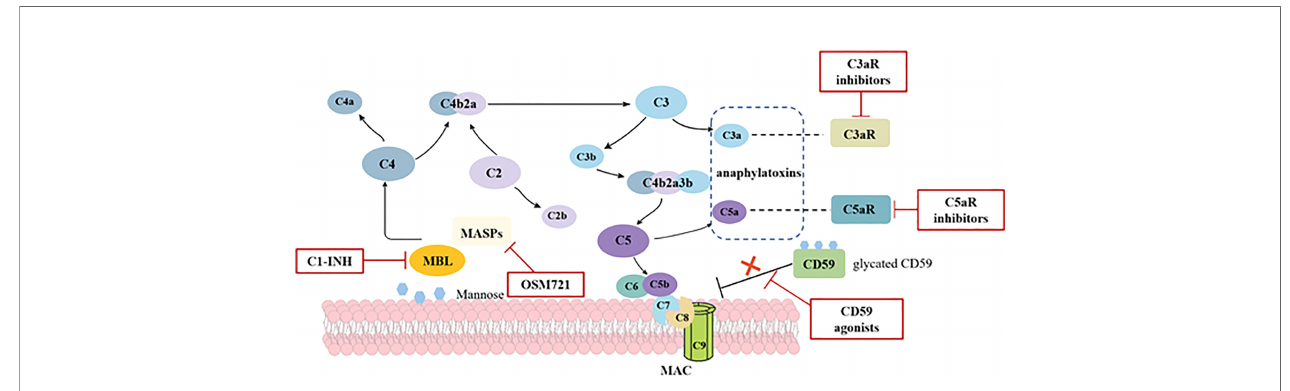
FIGURE 2 | Potential mechanisms and targets of complement activation in diabetic kidney disease. In diabetes, increased glycation of proteins leads to the activation of lectin pathway through MBL and the dysfunction of complement regulatory proteins. Hyperglycemia induces the inactivation of CD59, which is the key inhibitor of MAC formation, thus predisposing to MAC deposition. Anaphylatoxins C3a and C5a are also proved to participate in the pathogenesis of DKD. Potential complement-targeted therapeutics for DKD in red boxes include C1-INH, OSM721, C3aR inhibitors, C5aR inhibitors, and CD59